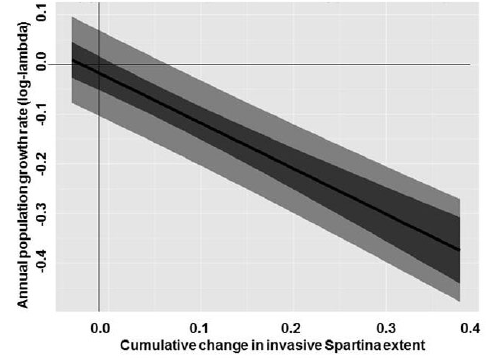
Fig. 2 . Average annual rate of California Ridgway’s Rail population change between 2005 and 2012 relative to the cumulative change in extent of invasive Spartina within 22 marsh complexes in San Francisco Bay. Population rate of change expressed as the logarithm of lambda; positive values indicate population growth, and negative values indicate decline. Confidence interval, accounting for variance from fixed effects only, is represented by the dark gray interval. The prediction interval, which includes fixed effect and random slope variance, is represented by the light gray